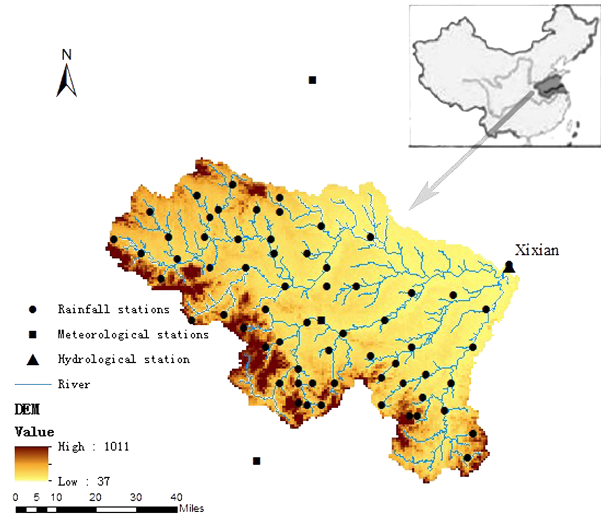
Figure 1. The location of Xixian